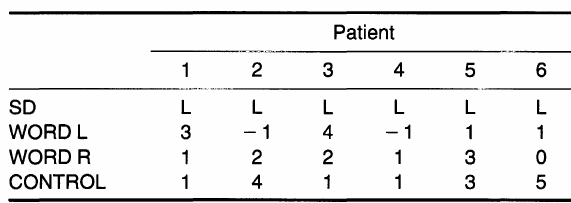
TABLE III. Speech dominance and word recognition scores